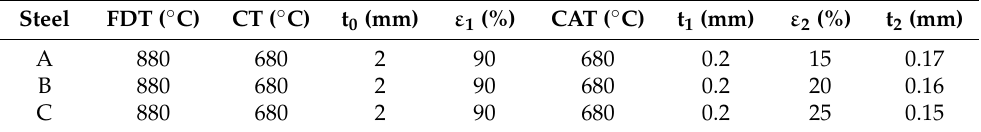
Table 2. Parameter control of production